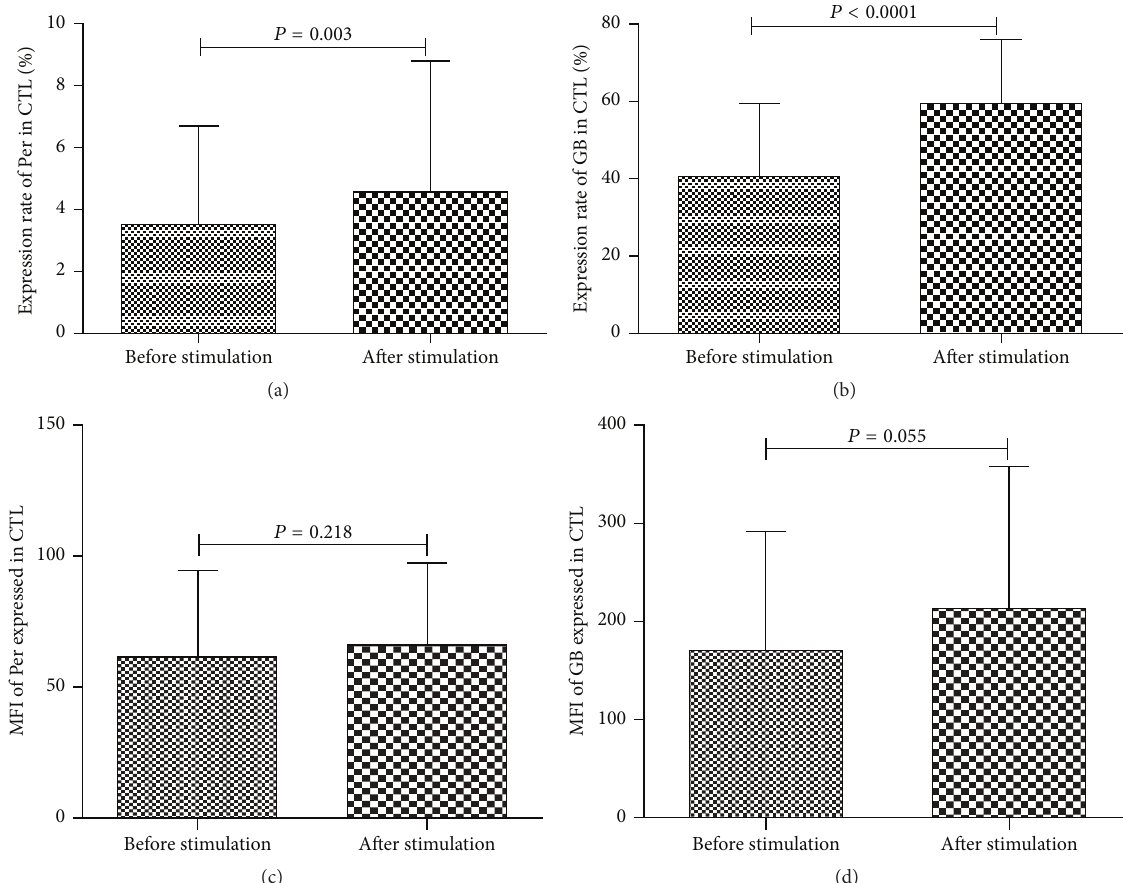
Figure 7: Th17 cells exert antitumor effects possibly through increasing Per and GB production by CTL. Expressions of Per and GB in CTLs before and after rhIL-17 stimulation were shown in (a) and (b). MFI of Per and GB expressed in CTL before and after rhIL-17 stimulation were shown in (c) and